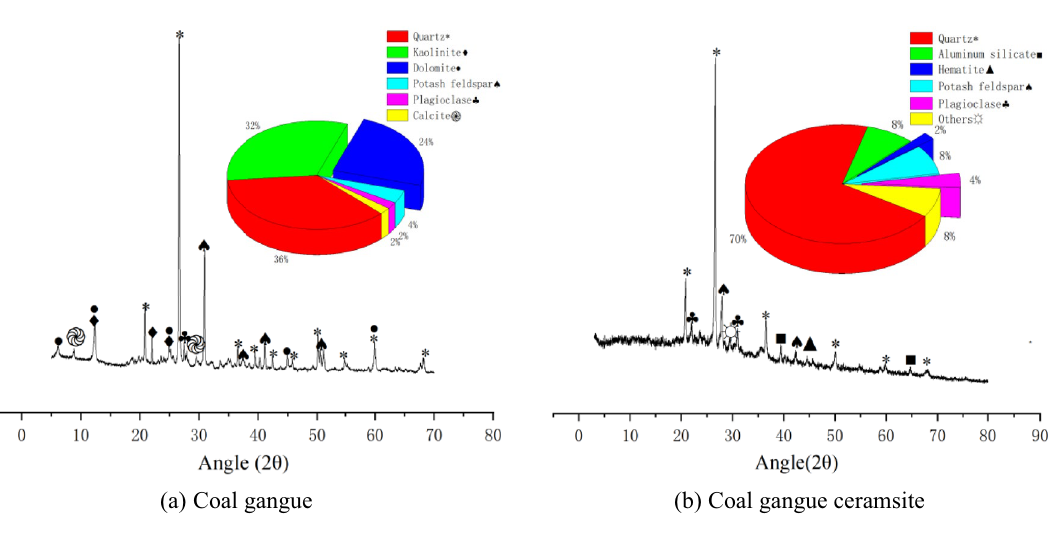
Figure 3. XRD spectra of coal gangue before and after